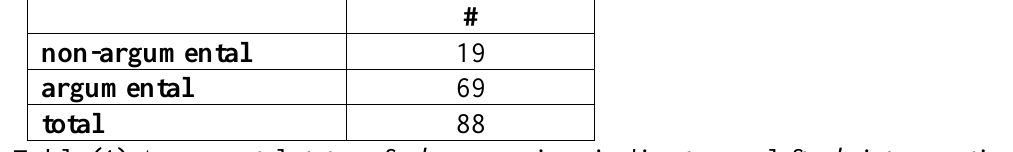
Table (4): Argumental status of wh -expressions in direct non-cleft wh -interrogatives with an overt subject